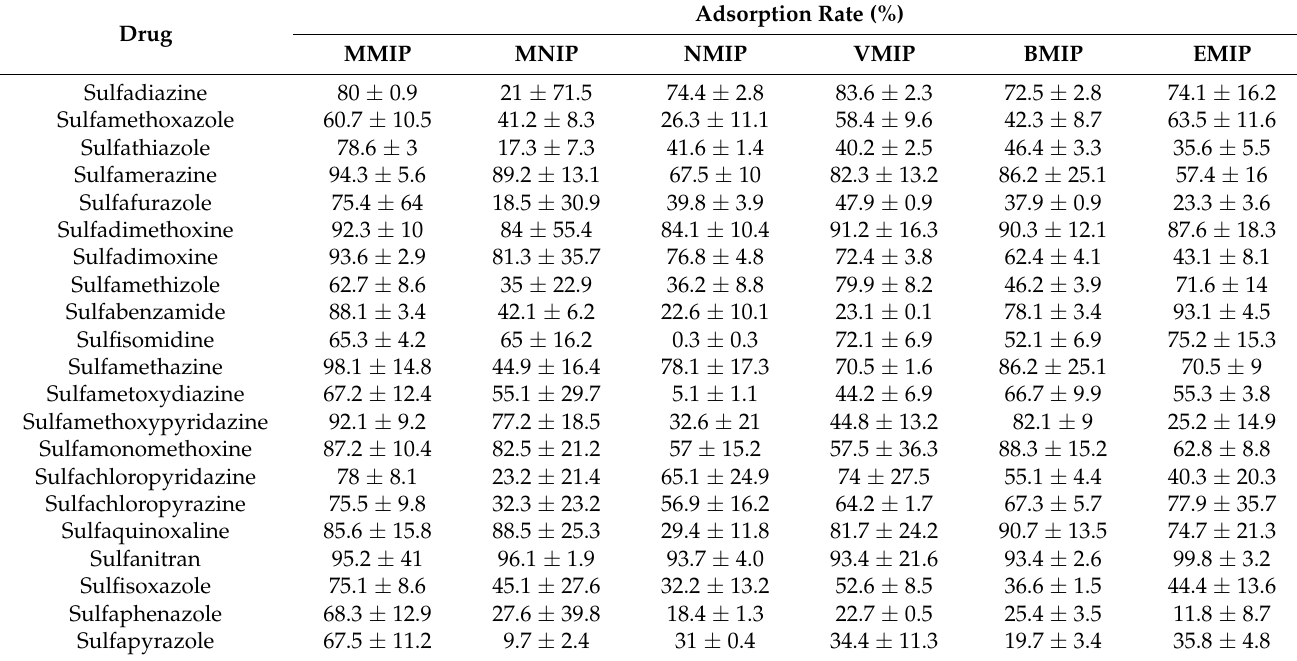
Table 1. Adsorption rates of 6 kinds of MIP.